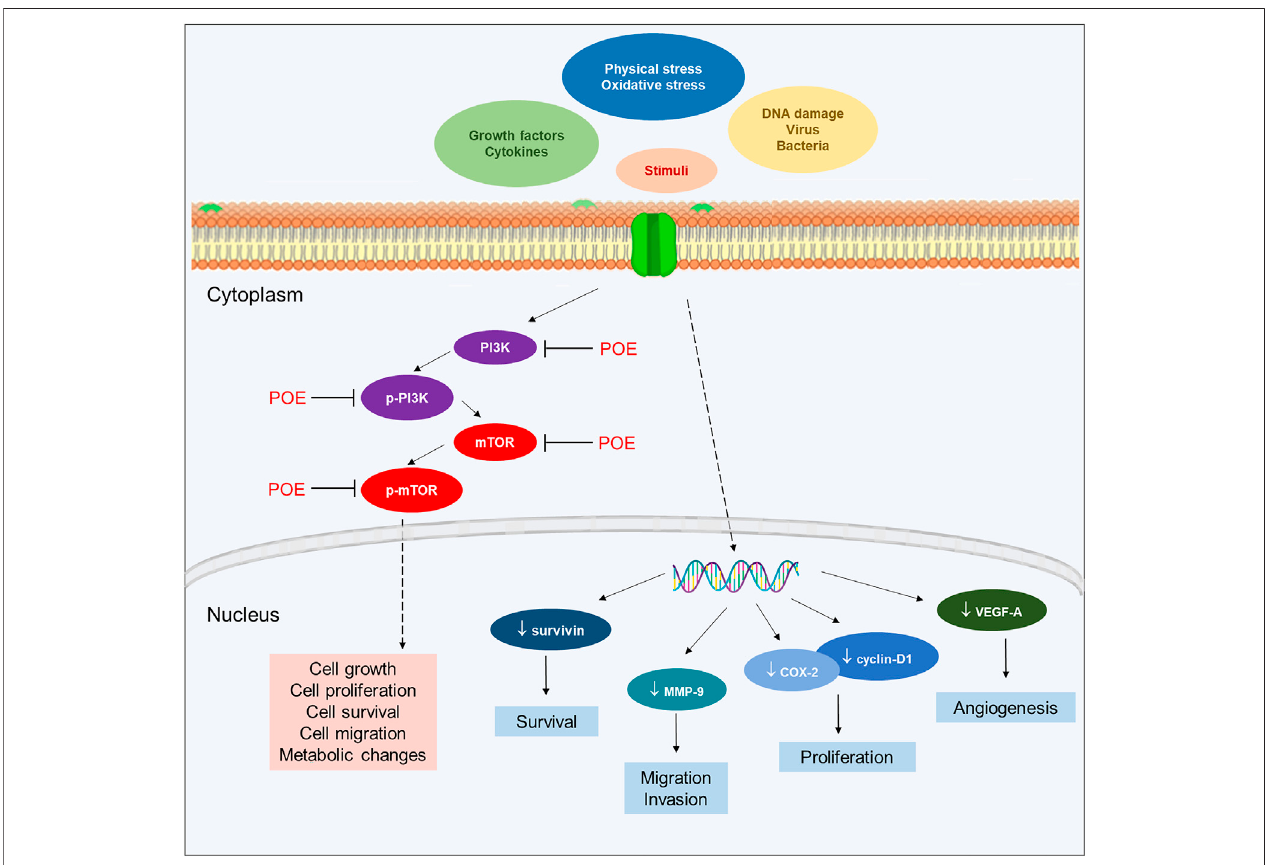
FIGURE 4 | Molecular mechanism of P. odoratum methanolic extract (POE) as anticancer in oral squamous cell carcinoma, SAS cell line, investigated by Devi Khwairakpam et al. (2019). POE inhibited the expressions of survivin; a member of the inhibitor of the apoptosis family, VEGF-A; a vascular endothelial growth factor, whichrepresentstheessentialrolesinangiogenesis,andMMP-9;anenzymeinvolvinginmetastasis.POEalsodownregulatedcyclin-D1;aproto-oncogene,whichplays an important role in the regulation of cell cycle, and COX-2; a membrane glycoprotein which plays a vital role in the early stages of tumorigenesis. Besides, the extractdownregulatedtheexpressionofPI3KandmTORandreducedtheirphosphorylation.Thus,POEaffectedcellgrowth,cellproliferation,cellsurvival,cellmigration and cell